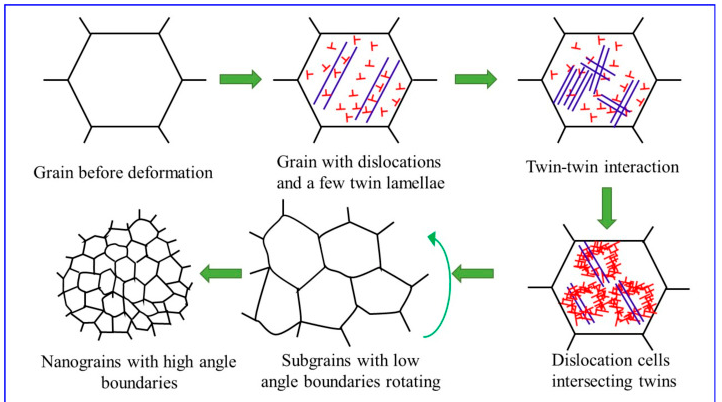
Figure 3. The illustration of grain refinement mechanism of Mg-8Gd-3Y alloy during SSP. Reproduced with permission from [70]. Copyright Elsevier, 2020.